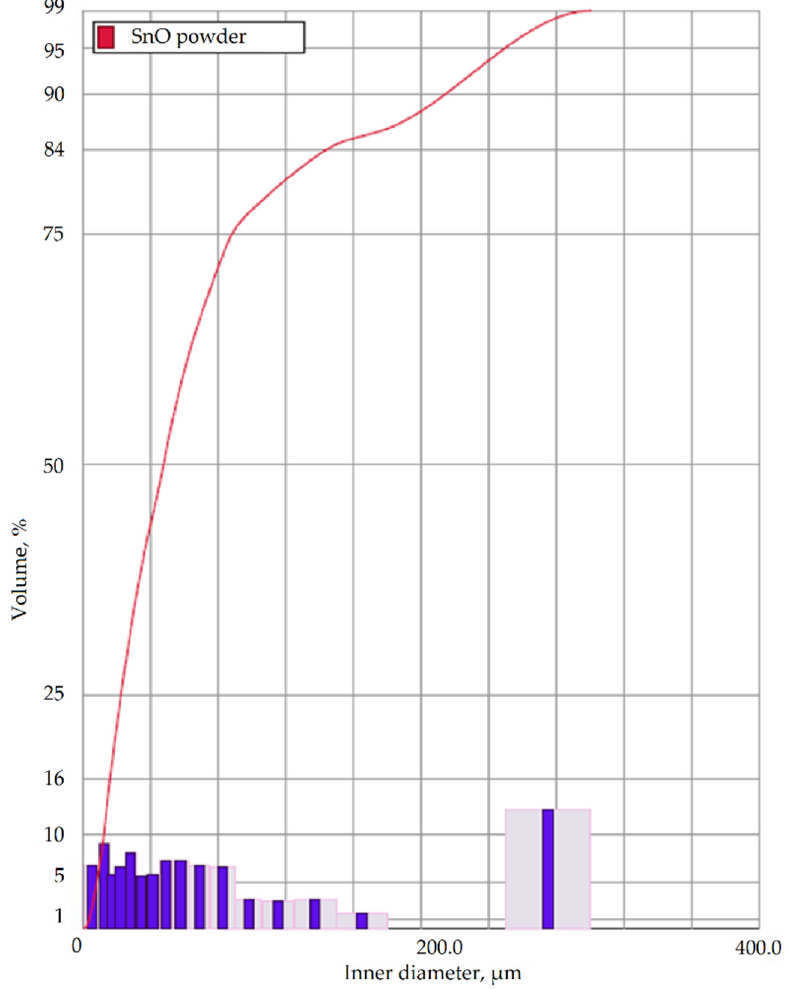
Figure 4. Granulometric analysis of the composition of tin oxide powder.